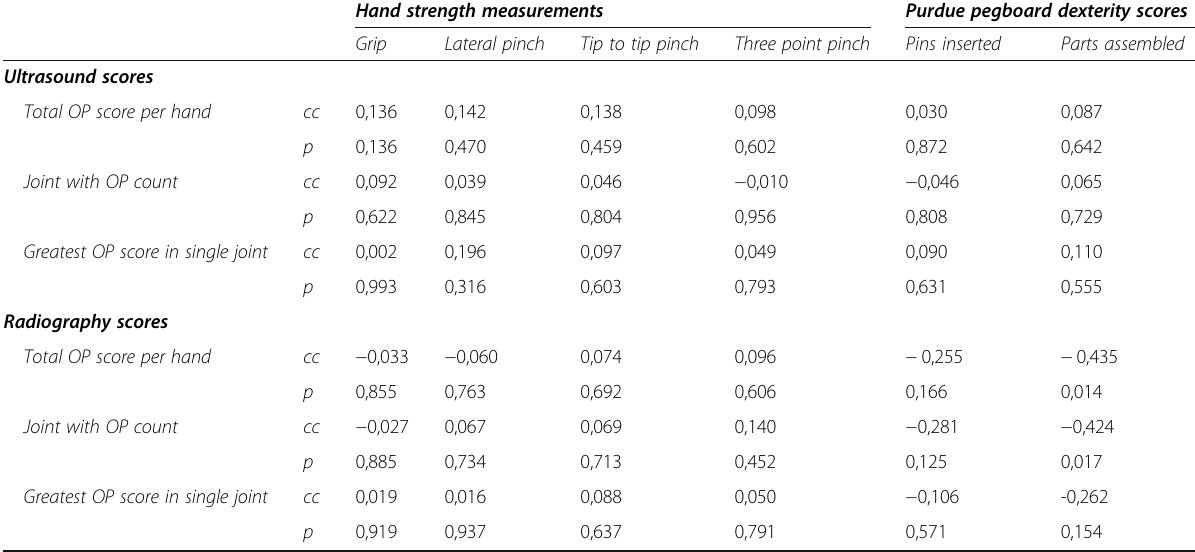
Table 4 Correlations between clinical findings, osteophyte scores and functional tests in hand osteoarthritis group Hand strength